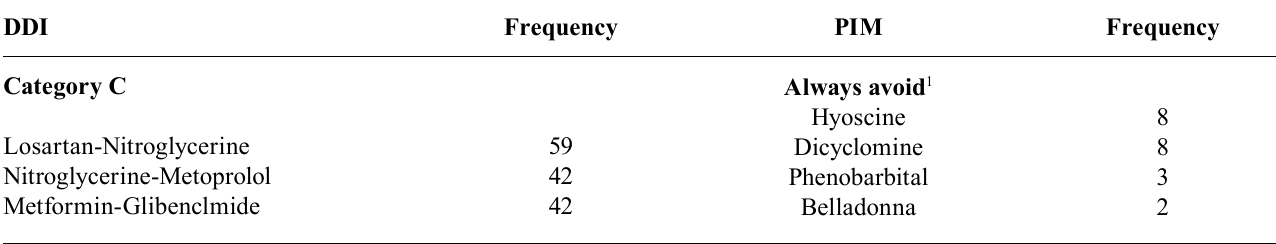
TABLE II – Frequent drug interactions within C, D and X category and frequency of potentially inappropriate medication